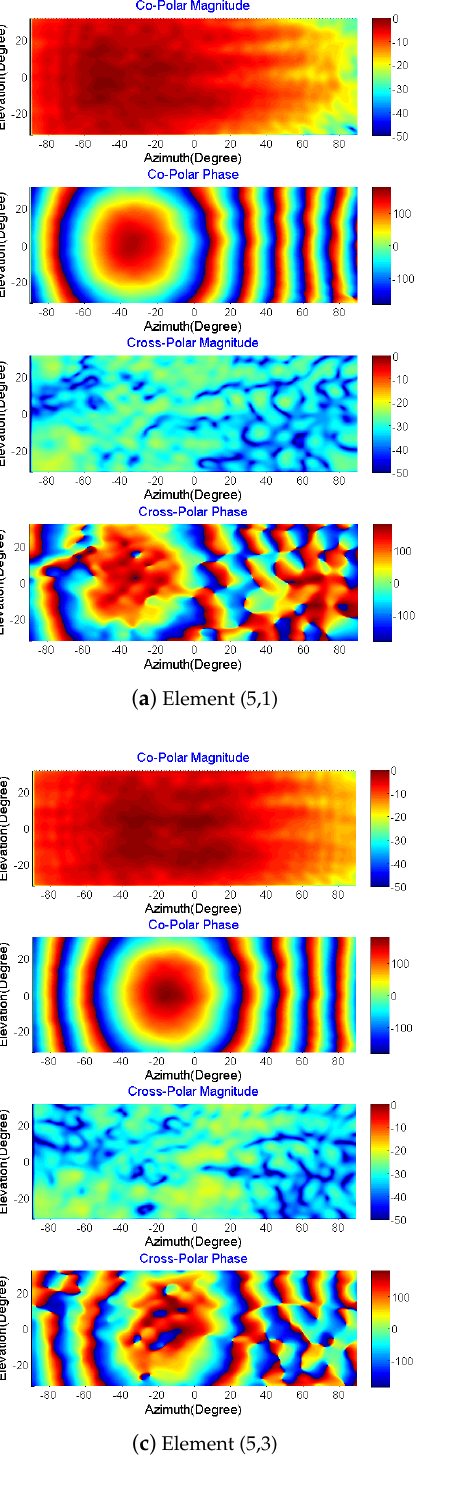
Figure 11. Measured AEPs of the (5,1) ( a ), (5,2) ( b ), (5,3) ( c ) and (5,4) ( d ) elements in the eight-by-eight faceted-cylindrical phased array antenna; co-polar magnitude in dB (first row), co-polar phase in degrees (second row), cross-polar magnitude in dB (third row) and cross-polar phase in degrees (forth